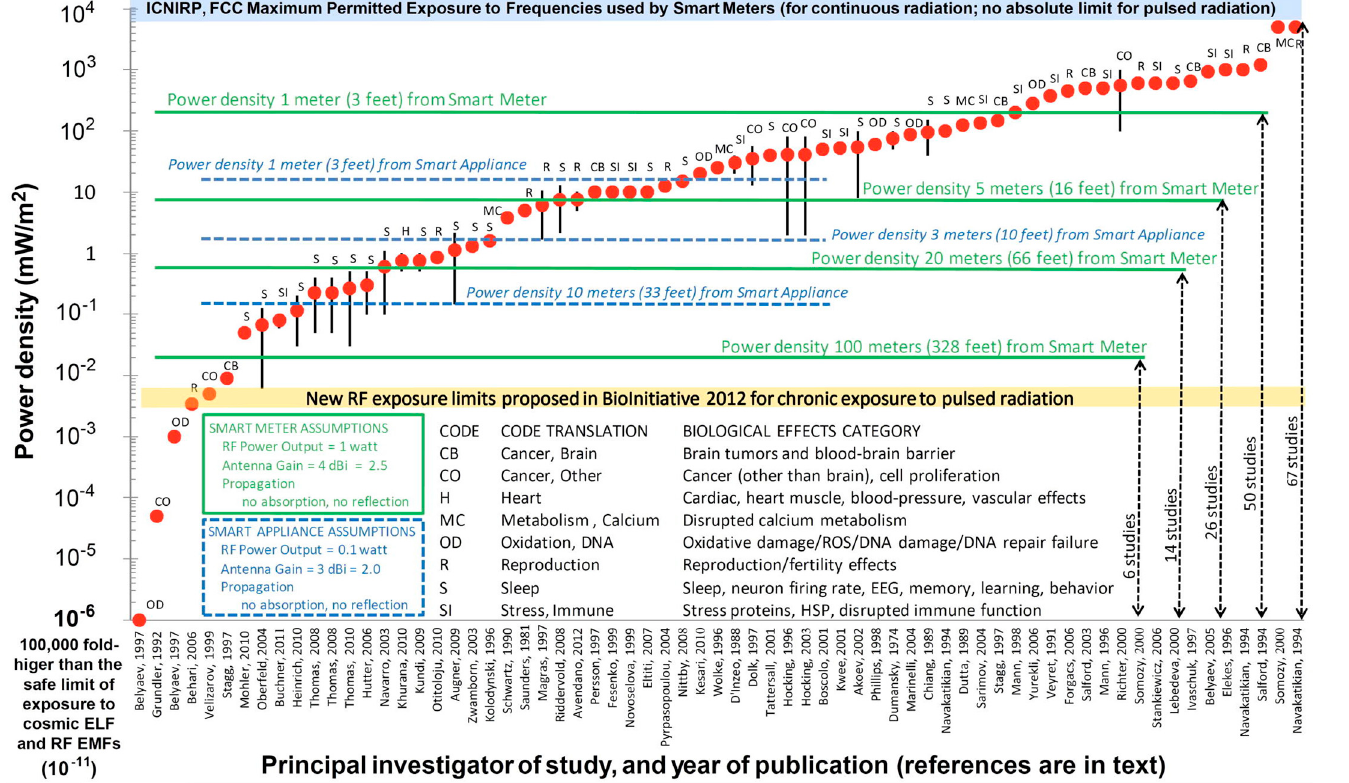
Figure 3. The biological effects of RF-EMF radiation with radiation power intensities lower of the International Commission on Non-Ionizing Radiation Protection/U.S. Federal Communications Commission (ICNIRP/FCC) exposure limit. The chart is a reference-updated and slightly modified from the original version [148].